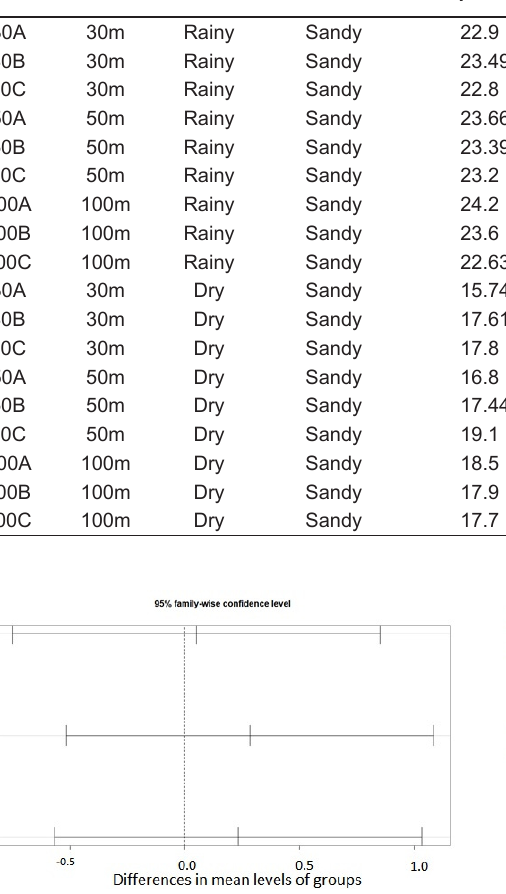
Figure 2. Post-hoc Tukey HSD test results of Organic Matter percentage in the sediment between riparian zone width categories.